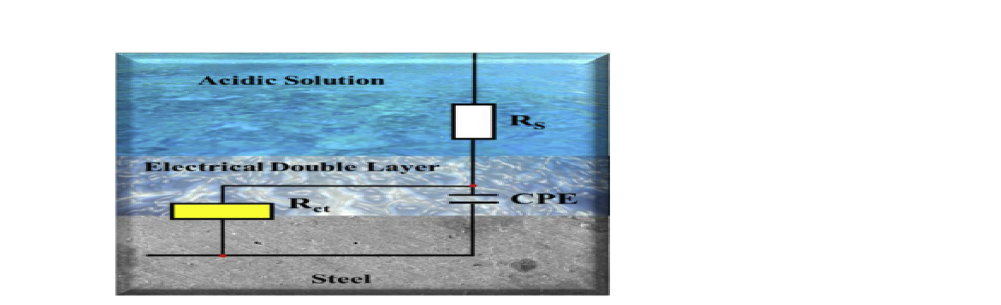
Figure 9. Equivalent circuit used to model metal/solution interface of C-steel in 1 M HCl without and with the cationic aryl bi-thiophene